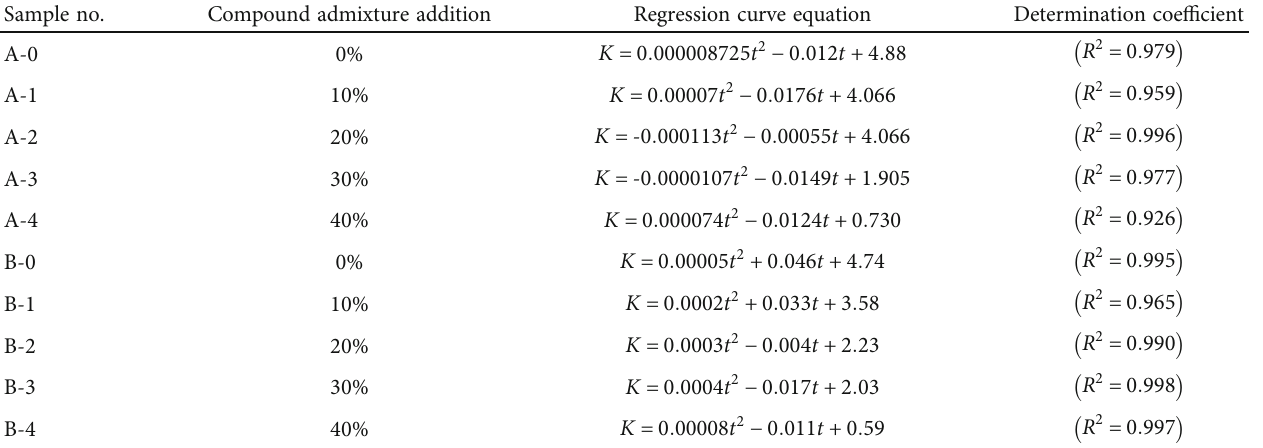
Table 5: Temperature and wildlife count in the three areas covered by the study. Sample no. Compound admixture addition Regression curve